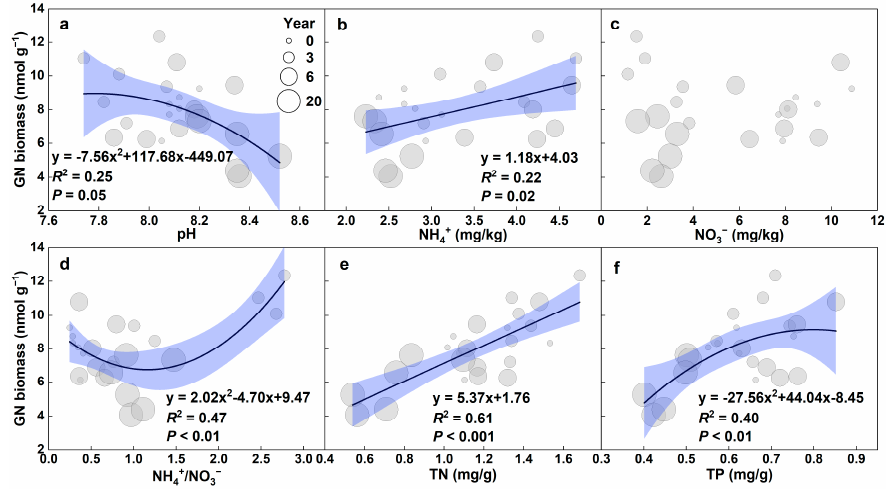
Figure 8. Relationships of Gram-negative bacterial biomass (GN biomass, nmol·g − 1 ) with soil properties (pH, ( a ); NH 4+ , ( b ); NO 3 − , ( c ); NH 4+ /NO 3 − , ( d ); TN, ( e ); TP, ( f )). See abbreviations in Table 2.